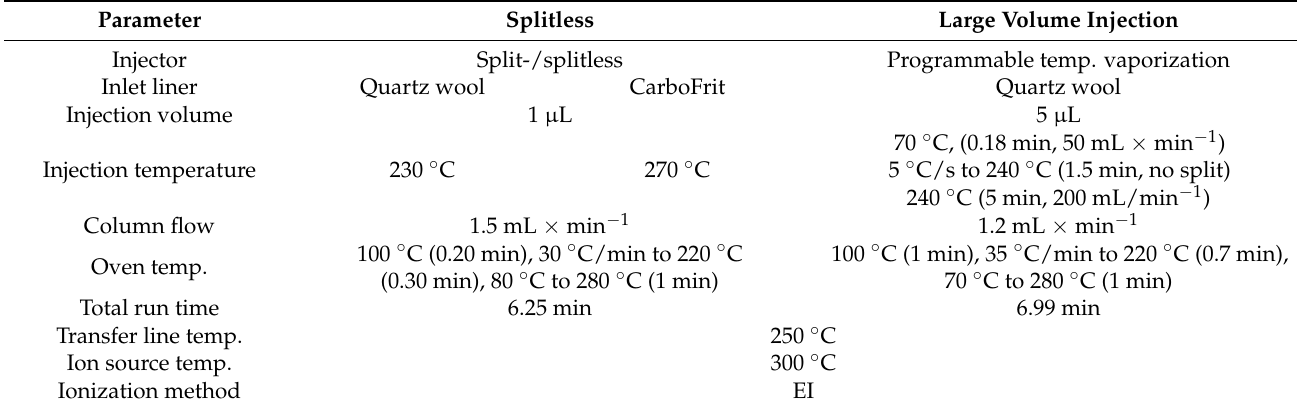
Table 1. GC-MS/MS programs for splitless and large volume